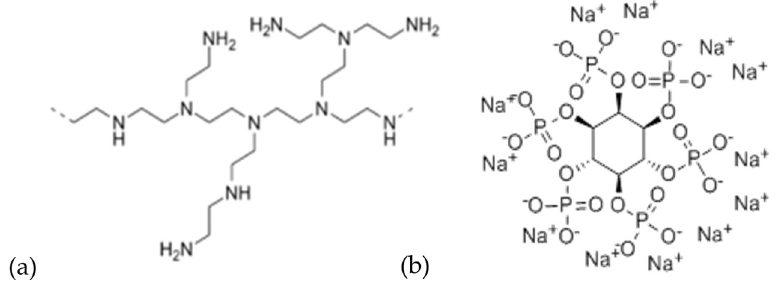
Figure 1. Branched polyethyleneimine ( a ) and sodium phytate ( b